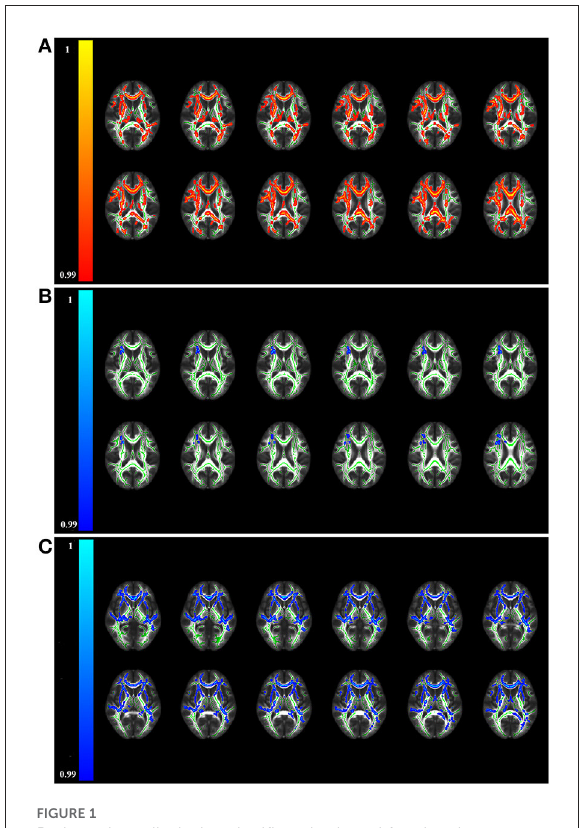
FIGURE1 Brain regions displaying significantly altered fractional anisotropy (A) , mean diffusivity (B) , and radial diffusivity (C) in patients compared to controls by TBSS analysis ( p < 0.01, FWE corrected). The red/yellow colors represent reduced FA in patients, while blue/light-blue colors represent increased MD and RD in patients relative to controls (color-coded according to the 1 - p -value). No significant differences in axial diffusivity were observed between the two groups. TBSS, tract-based spatial statistics.